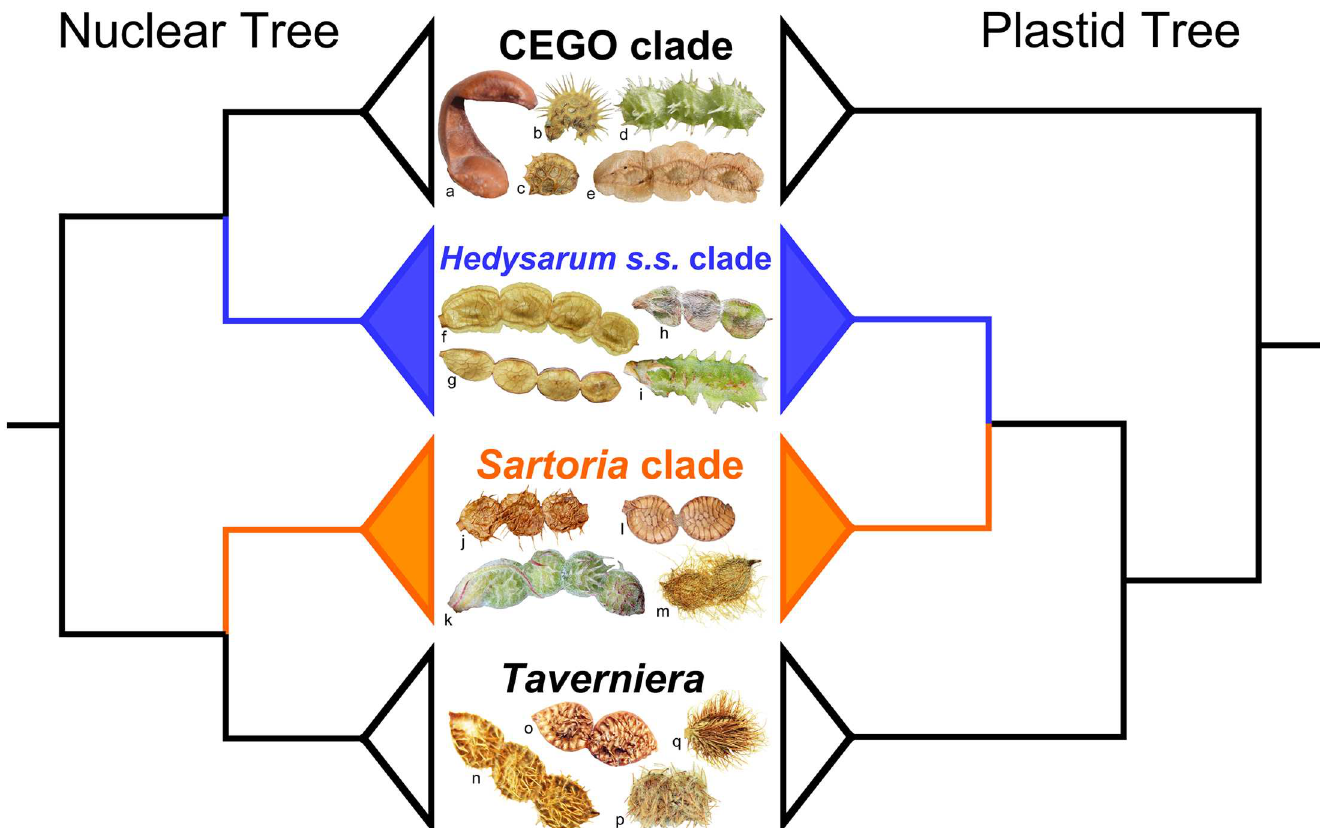
Fig 3. Summary of the incongruent position of the Hedysarums . s . clade in the nuclear (left) and the plastid (right) trees, with selected legume species from each clade (middle). The legumes:a, Eversmannia subspinosa B.Fedtsch.; b, Onobrychisatropatana Boiss.; c, O . viciifolia Scop.;